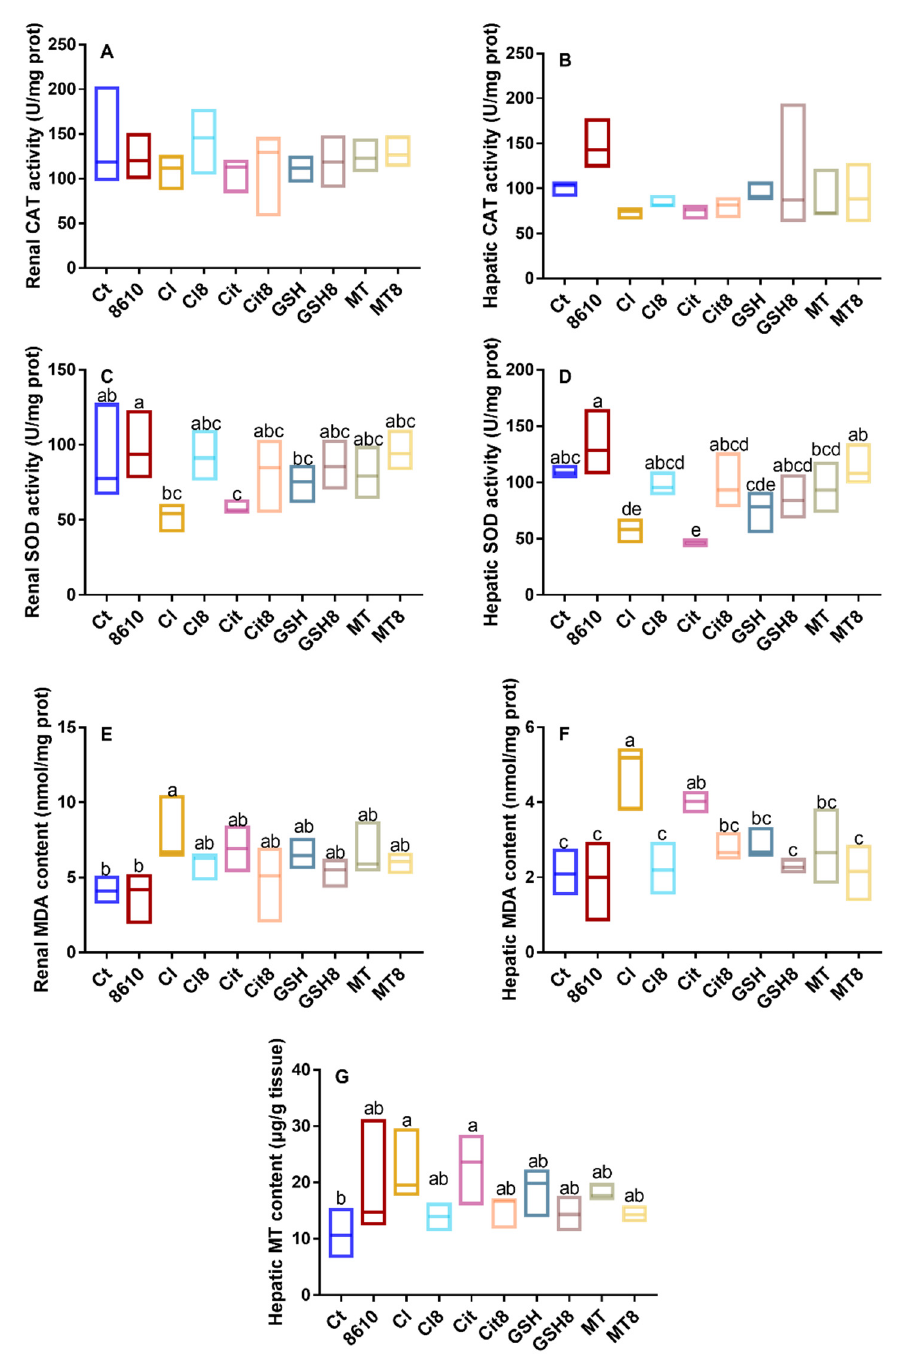
Figure 2. Changes in antioxidant indexes in the liver and kidneys of mice. ( A ). CAT in the kidneys. ( B ). CAT in the liver. ( C ). SOD in the kidneys. ( D ). SOD in the liver. ( E ). MDA in the kidneys. ( F ). MDA in the liver. ( G ). MT in the liver.